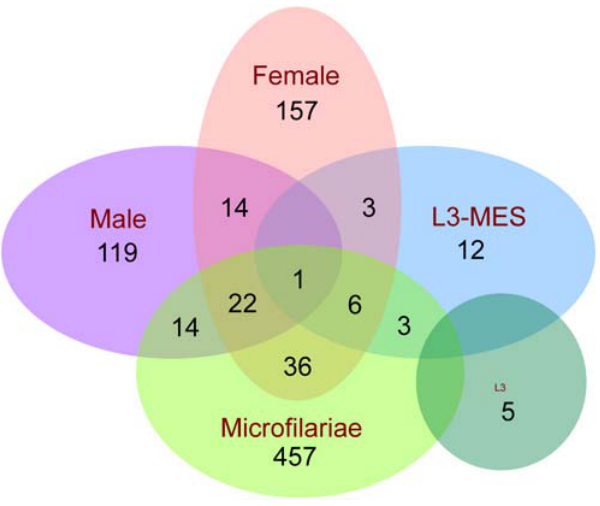
Figure 1. Stage specific distribution of ES in the adults, microfilariae, L3 larvae and L3 larvae molting to L4 of Brugia malayi . Proteins identified arerepresented as a Venn diagram, illustrating the overlap in proteins detected in the adult male, adult female, microfilarial and larval stages of B.malayi . The numbers indicate the total number of proteins detected in each of the stages. The complete listing of each of these proteins along with the peptides identified are given in Table S2, Table S3, Table S4, Table S5, and Table